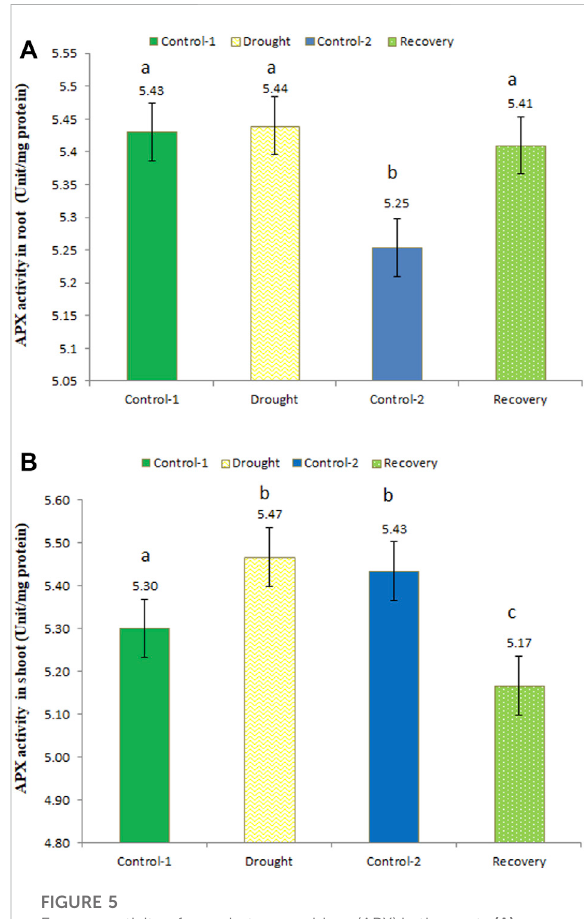
FIGURE 5 Enzyme activity of ascorbate peroxidase (APX) in theroots (A) and shoots (B) of wheat under control, drought, and recovery stages. The data represent the mean of three independent replications. Different letters above the column indicate signi fi cant changes when determined through Tukey ’ s HSD